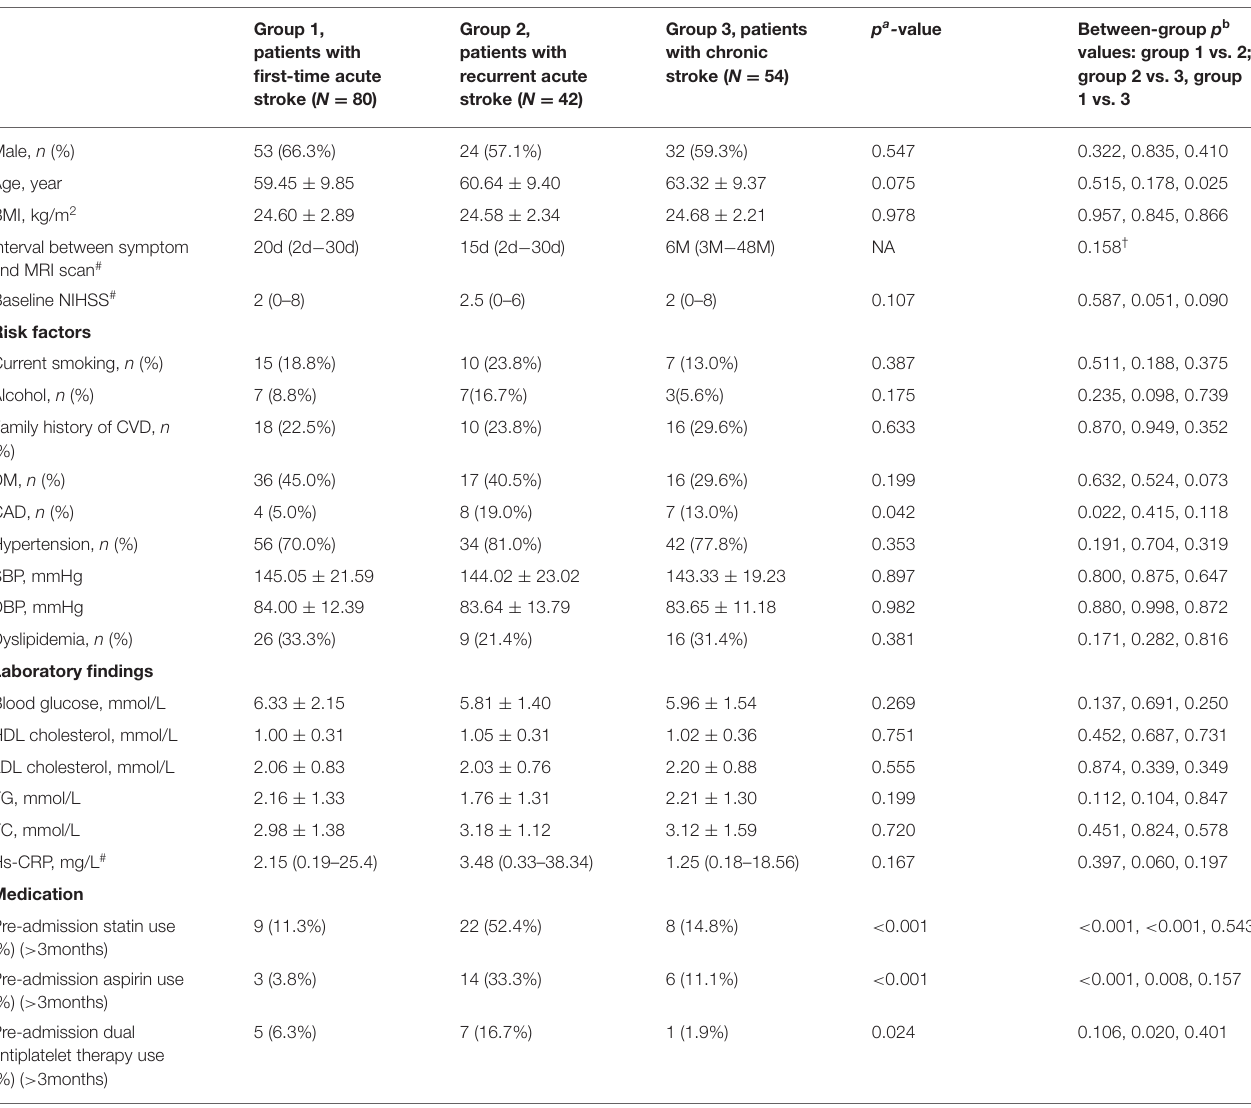
TABLE 1 | Demographic information of the study population.